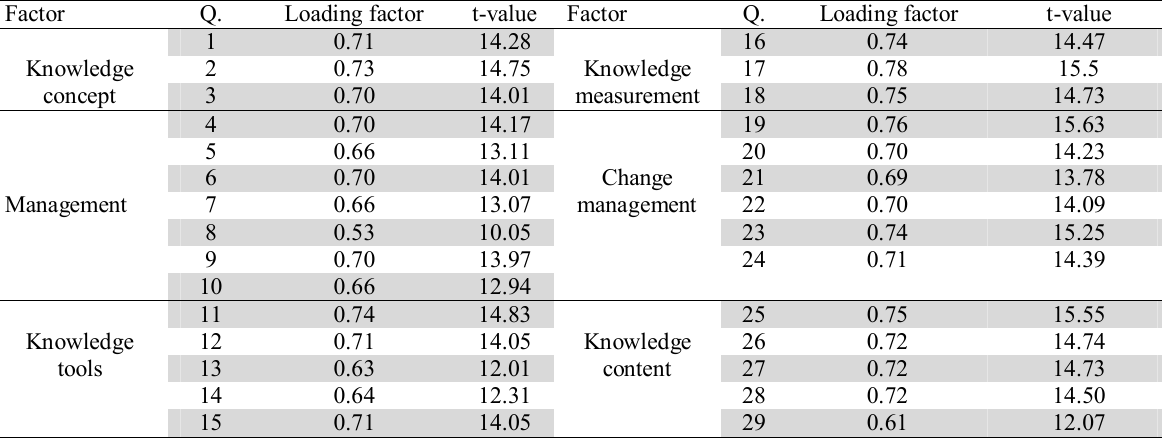
The summary of the results of factor analysis